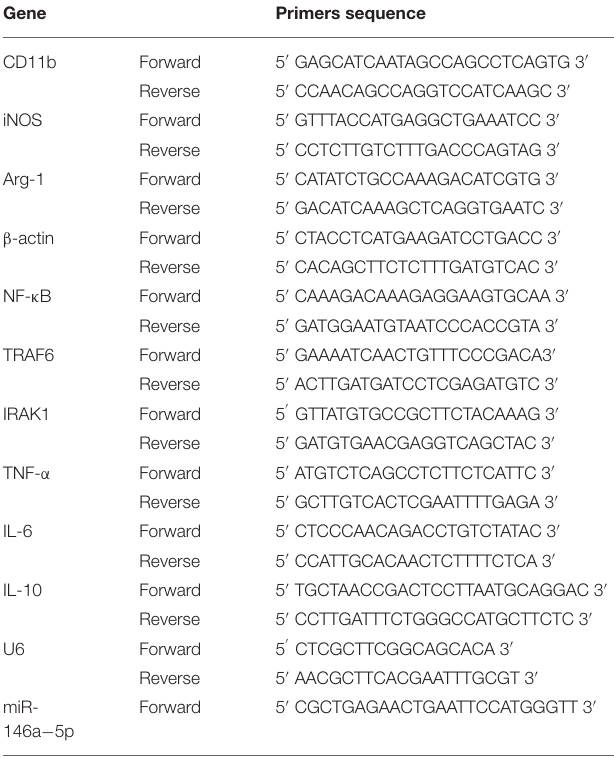
TABLE 1 | Primers of qRT-PCR.